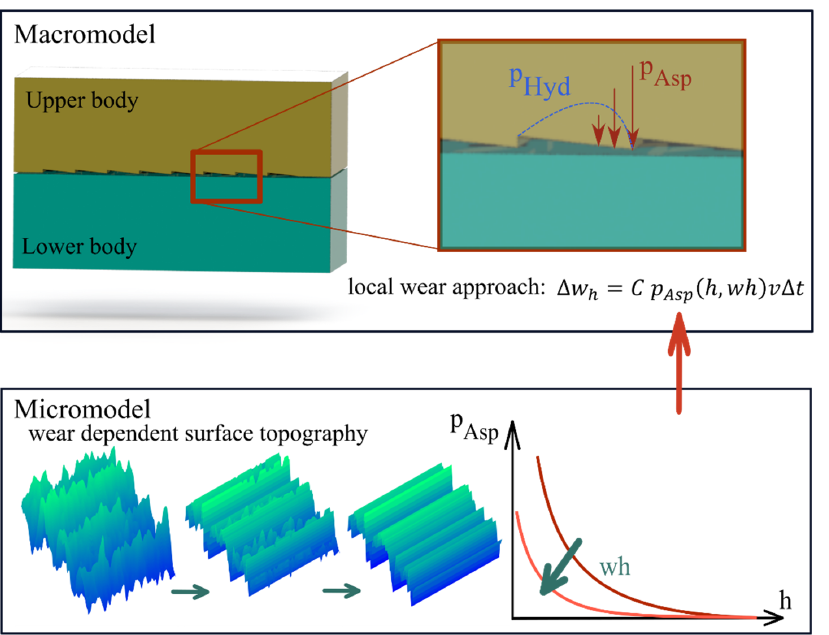
Figure 2 . Methodical approach—interaction of the macro and micro models. For this investigation, in addition to the smooth lubrication wedge geometry, vari ‐ ants with wedge ‐ shaped texture geometries on the upper lubrication gap surface were analyzed. The lubrication gap geometry is shown in Figure 3. A parameter study was per ‐ formed by varying the texture depth h t . Texture heights of 5, 10, 20, and 50 μ m were used.